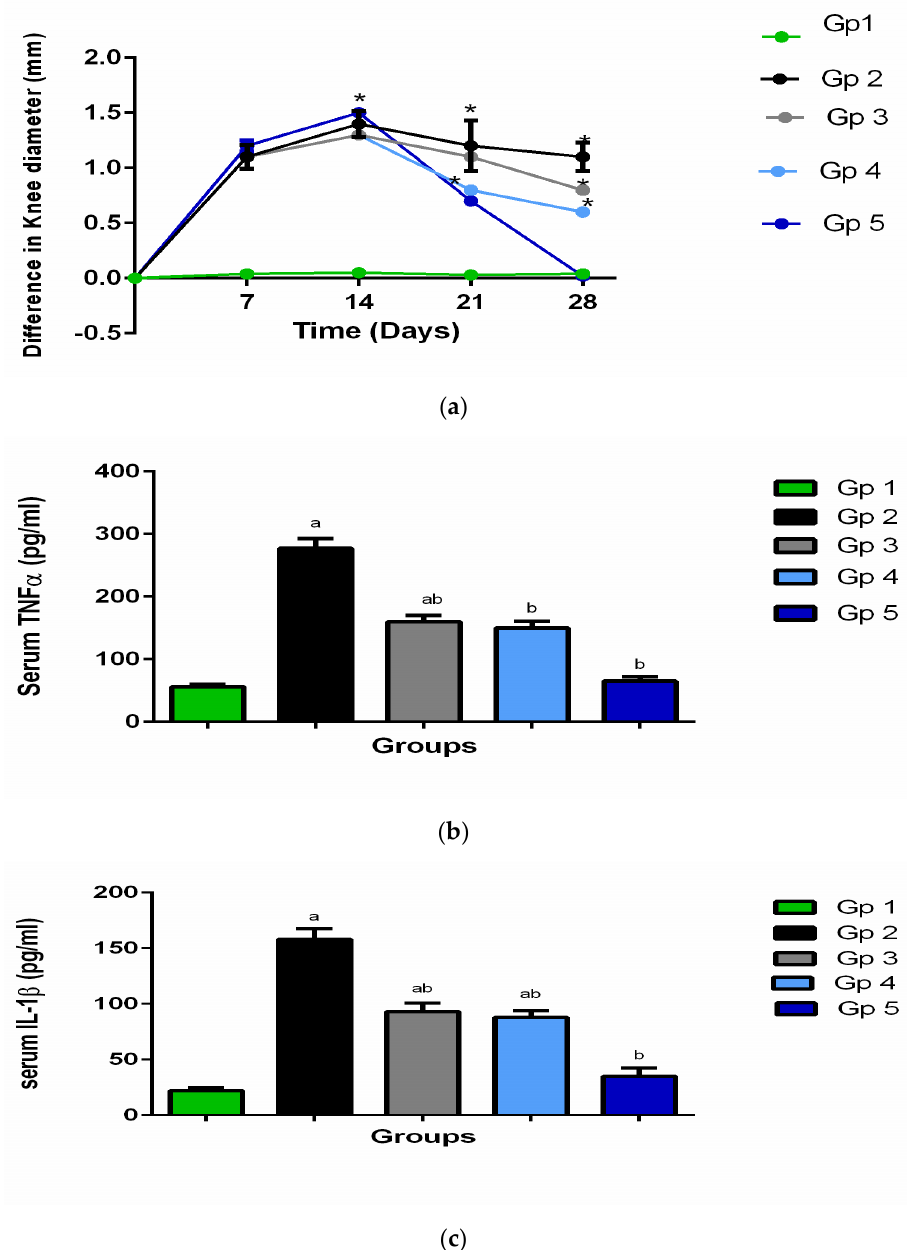
Figure 6. ( a ) The knee swelling for GP1 (negative control), GP2 (positive control), GP3 (Blank hyaluosome), GP4 (DCN aqueous dispersion), and GP5 (optimized DCN loaded hyaluosomes (F7)); ( b ) The rat’s plasma TNF- α levels; ( c ) The rat’s plasma IL-1b levels. a Significantly different from negative control group at p < 0.05, * or b Significantly different from positive control group at p < 0.05, ab Significantly different from both negative and positive control group at p <